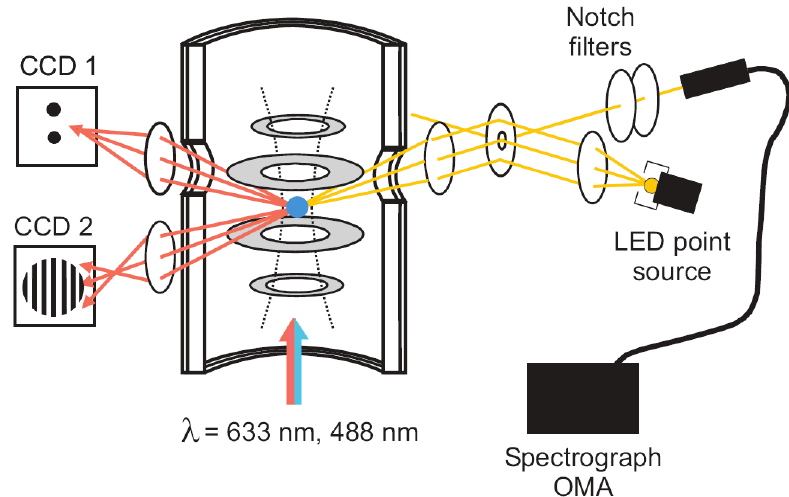
Fig. 8. Schematic with the electrodynamic balance experimental setup (Duft and Leisner, 2004a; Zardini et al.,